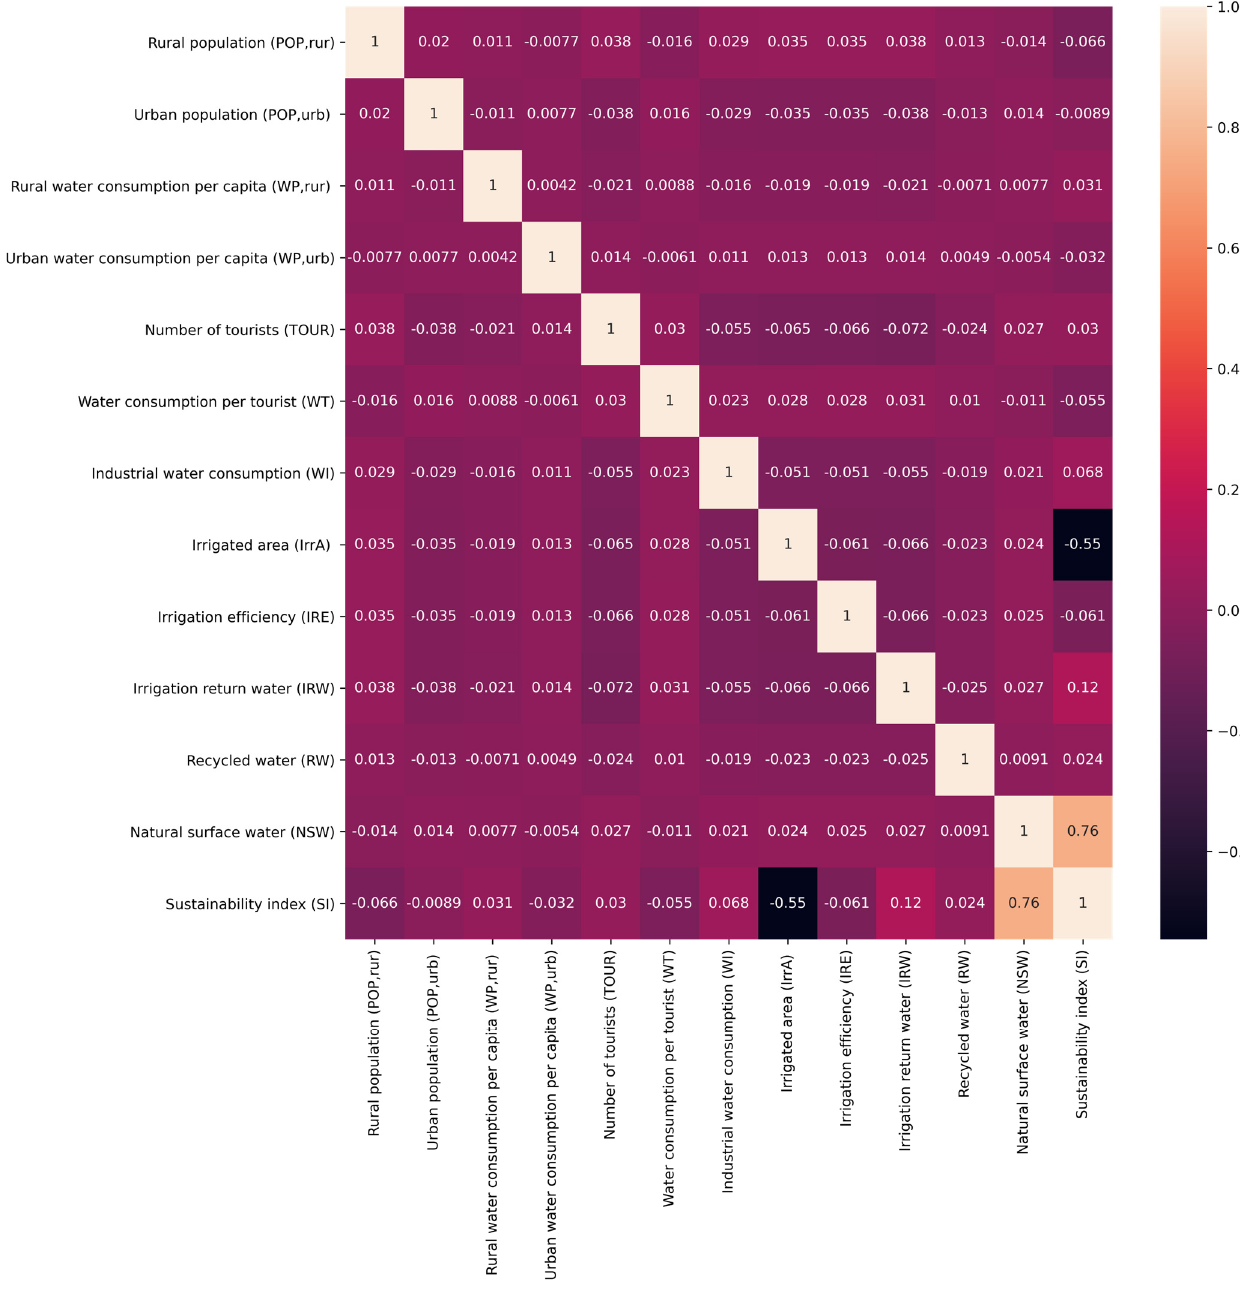
Figure 8. Correlation matrix of the System Dynamics model